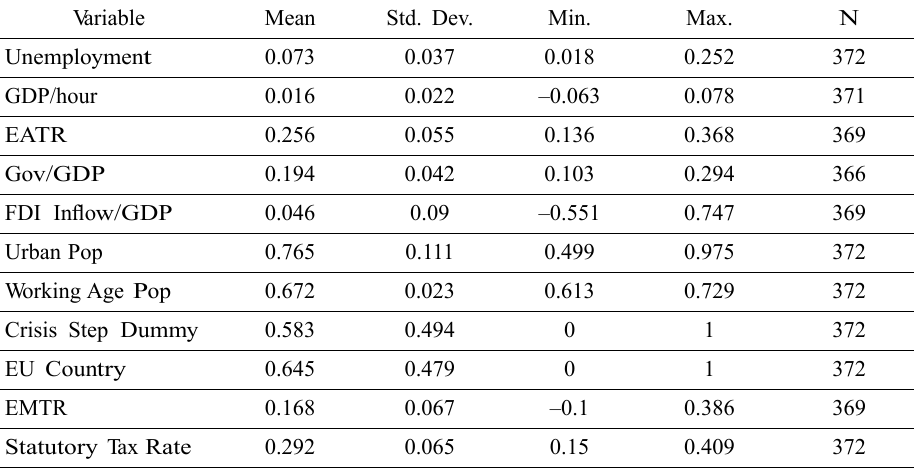
Table 1. Summary